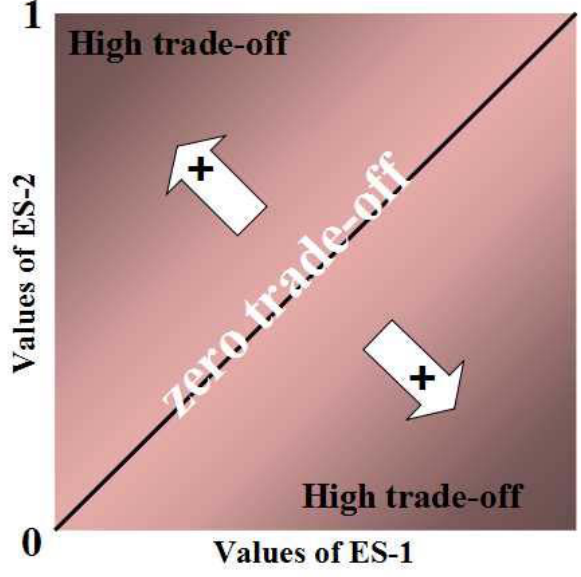
Figure 3. Illustration of overall trade-off between two ecosystem services. Illustration of overall trade-off between two ecosystem services. The overall Trade-off is calculated as the RMSE of the individual benefits and increases with distances from the 1:1